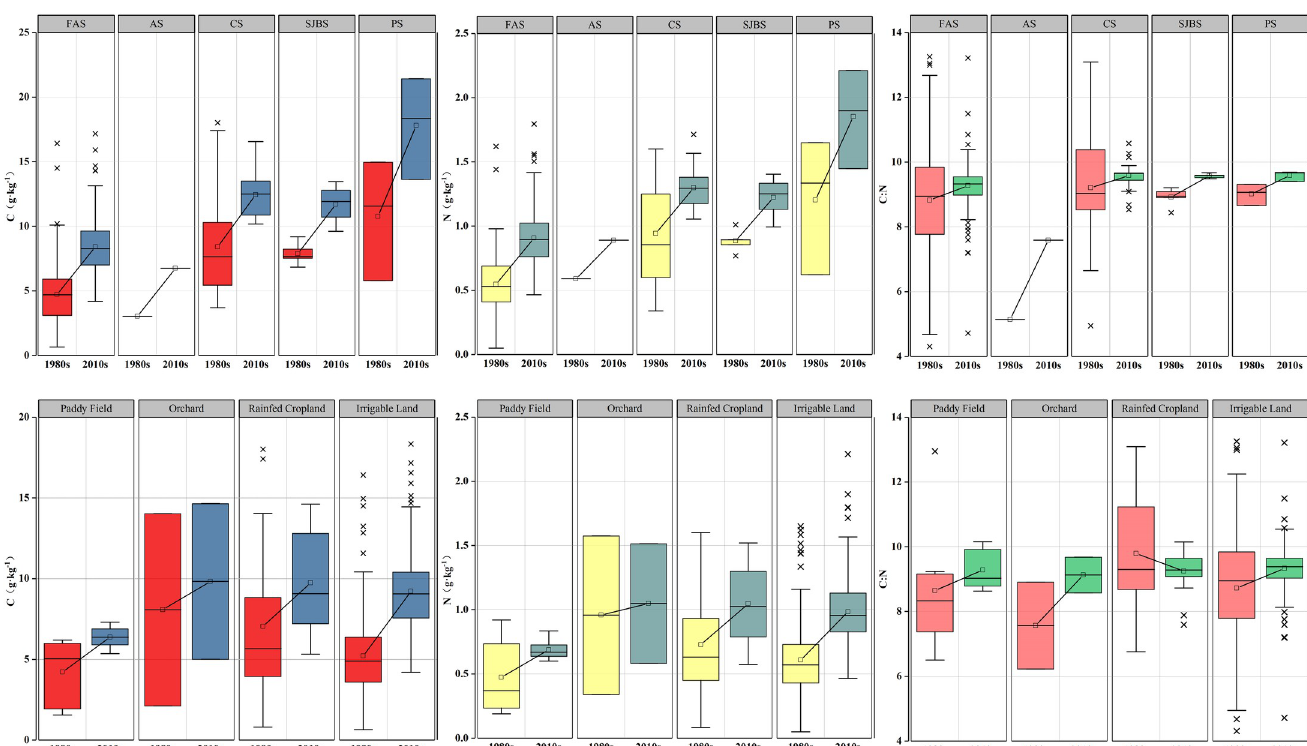
Fig 4. C, N contents and C:N stoichiometry in different soil types and agricultural land-use types (FAS: Fluvo-aquic soil, AS: Aeolian soil, CS: Cinnamon soil, SJBS: Shajiang black soil, PS: Paddy soil.).